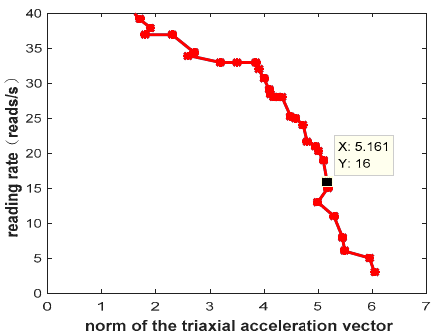
Figure 6. The relationship between norm of the acceleration vector and reading rate.